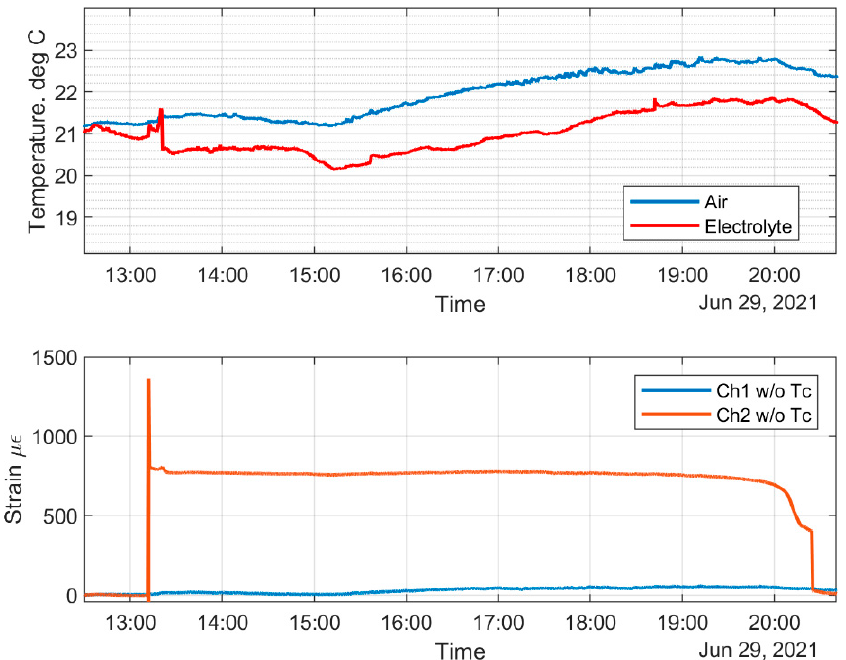
Figure 18. Top plot: air temperature versus electrolyte temperature. Bottom plot: strain measured on both corrosion detection sensors without temperature compensation.